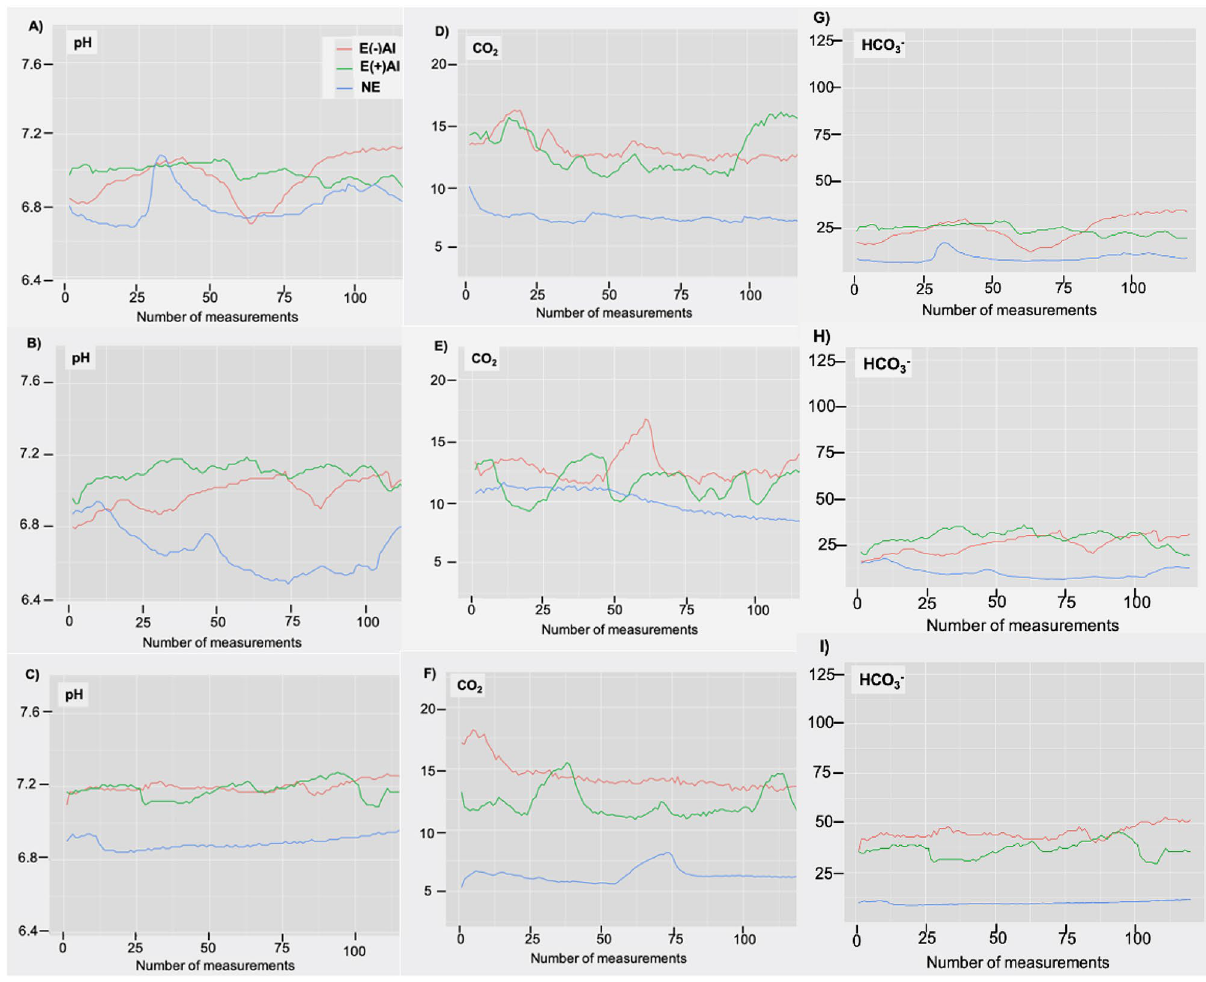
Figure 1. Plots of the timeline of uterine levels of pH (A–C) , CO 2 (%) (D–F) and HCO 3 − (mMol) (G–I) at the three experimental conditions in three selected sows. Corresponding figures for the same animal are horizontally displayed. Lines are a continuous representation of a set of 120 individual measurements (1 dot was recorded every 5 s for 10